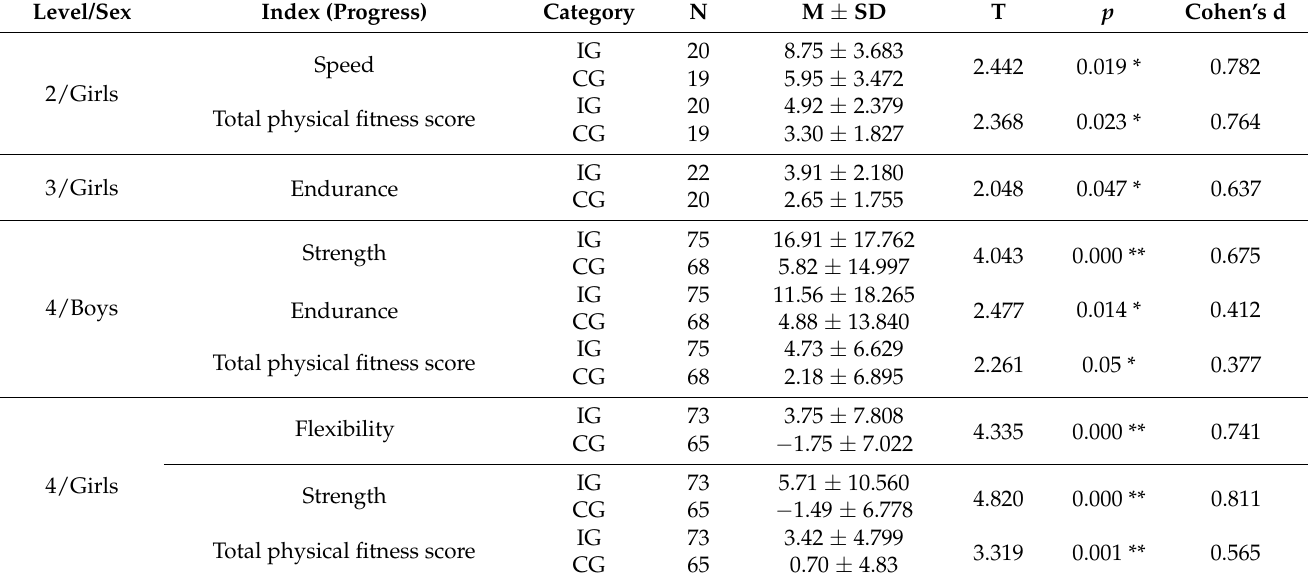
Table 7. Independent-samples t test analysis table for the improvement of children and adolescents’ physical fitness scores by gender and level in the IG and